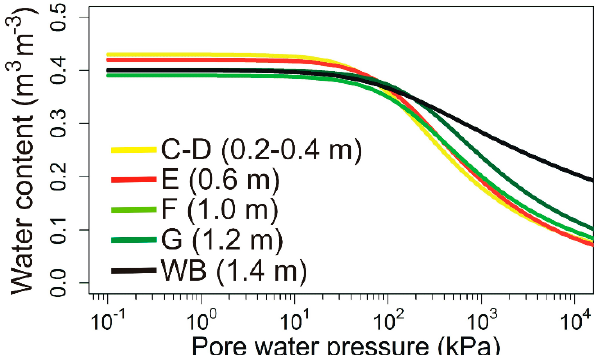
Figure 5. Soil water retention curves(SWRCs) of the soil horizons at the testsite.